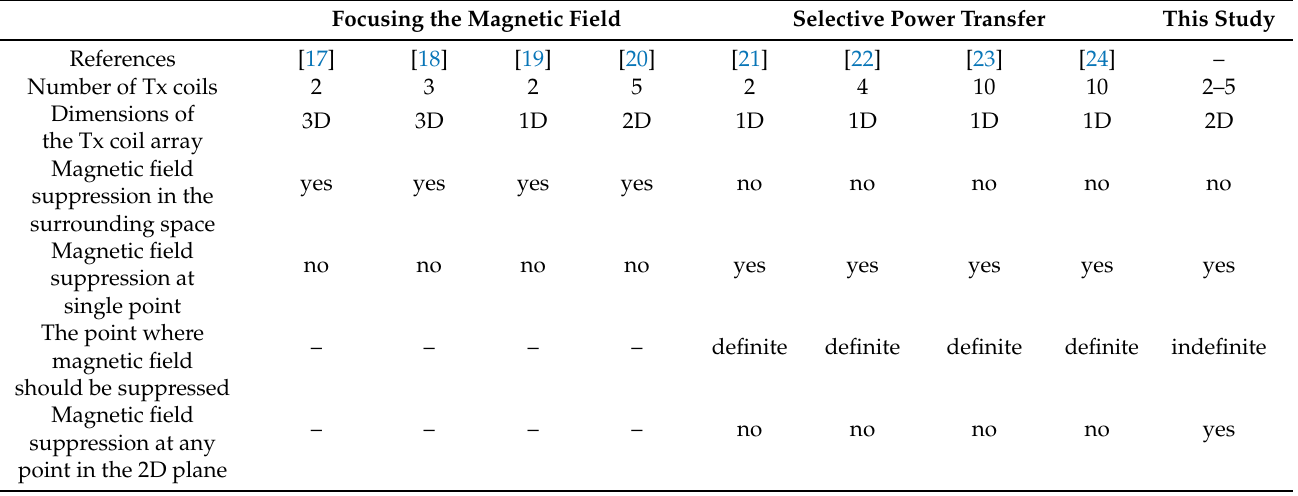
Table 1. Comparison among existing studies on magnetic Field control using phased array